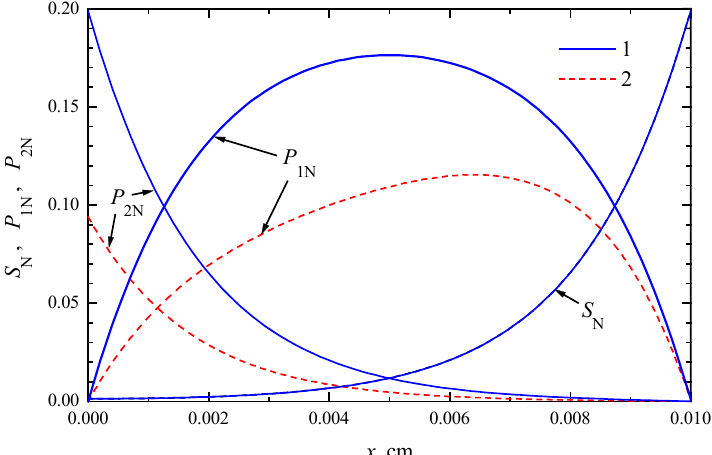
) and products ( P , P ) N 1N 2N = V = 100 1 2